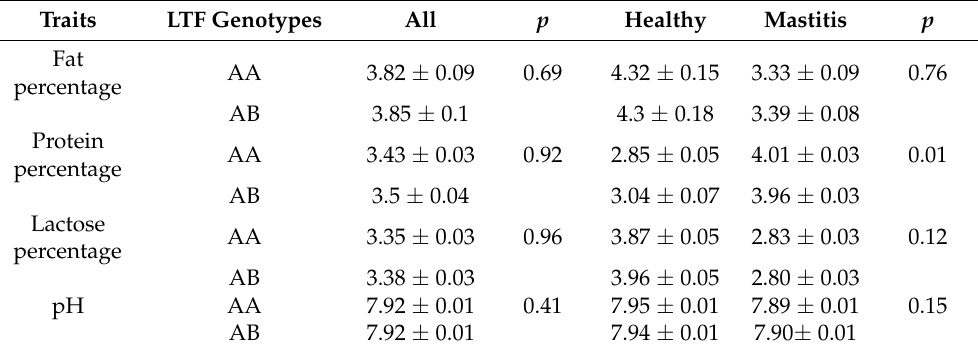
Table 4. Association between milk components with the Lactoferrin (LTF) genotypes and interactions between Lactoferrin genotypes and mastitis.